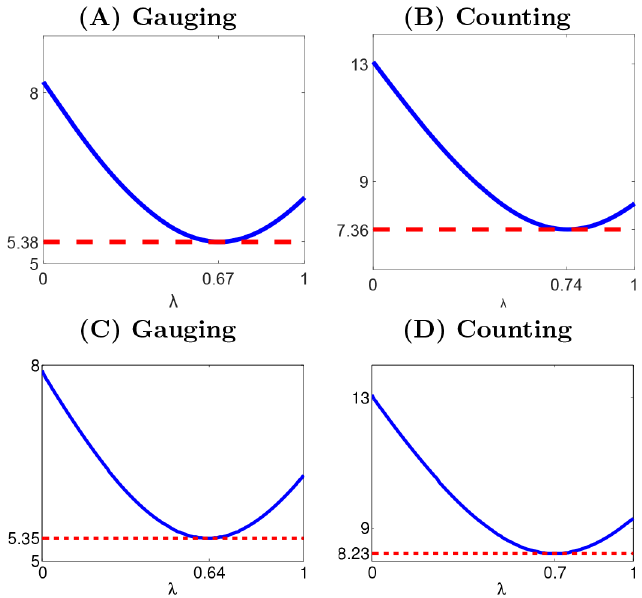
Fig 8. Root mean square intrinsic variation as a function of the λ parameters. (A), (B): the second round judgments, as given in Eq (3). (C), (D): the third round judgments, as given in Eq (5). (A), (C) gauging game , (B), (D) counting game